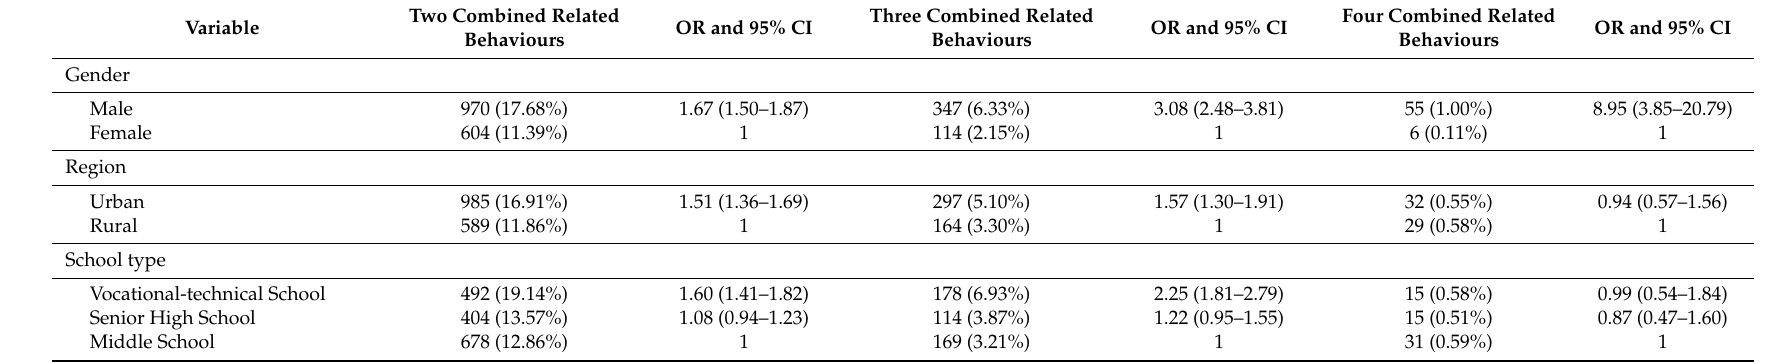
Table 3. Combined behaviours characteristics of unintentional injury in the student